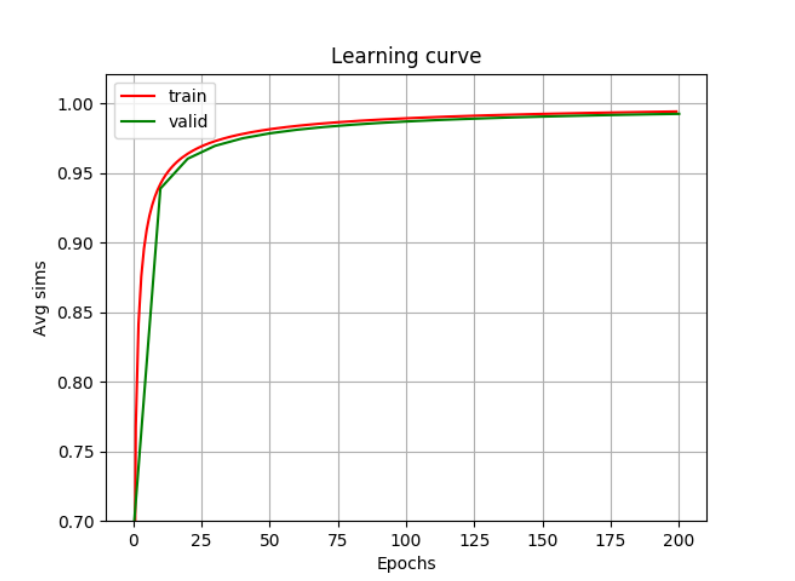
Figure 3. Learning curve of experimenting with SVD at the beginning (svd_mode =